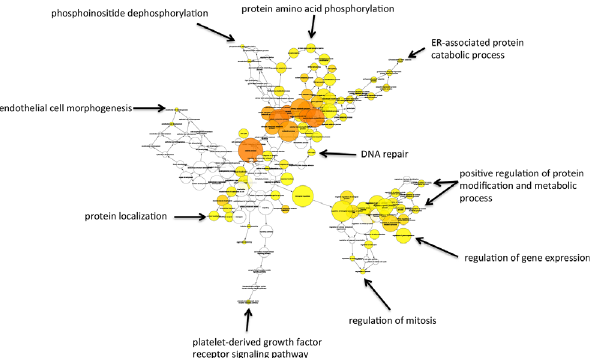
Fig 4. Network of gene ontology terms significantly ( P < 0.05) associated with the genes that were downregulated after hypoxia. The intensity of the color of each node denotes statistical significance ( i . e ., orange greater statistical significance than yellow, and uncolored nodes are not statistically significant). All nodes labeled with arrows are statistically significant.